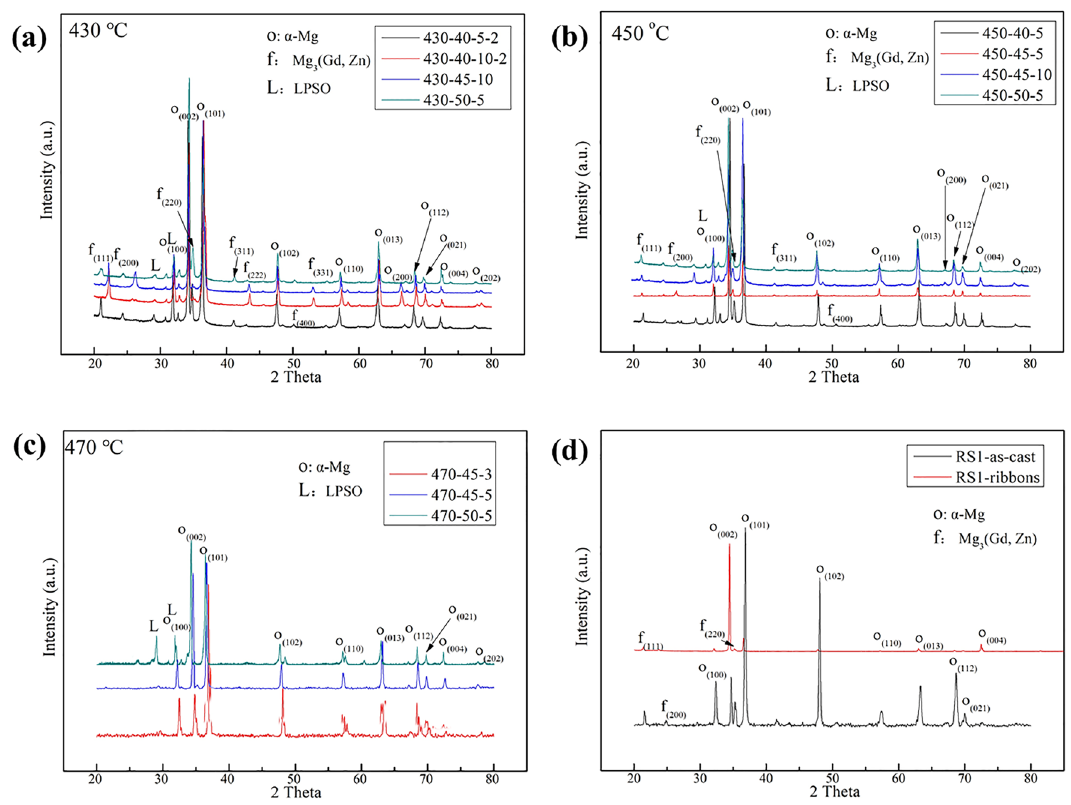
Figure 3. XRD patterns of the Mg–15Gd–1Zn alloy under different sintering conditions: ( a) at 430 °C; ( b) at 450 °C; ( c) at 470 °C; ( d) the RS ribbon and its as-cast ingot.